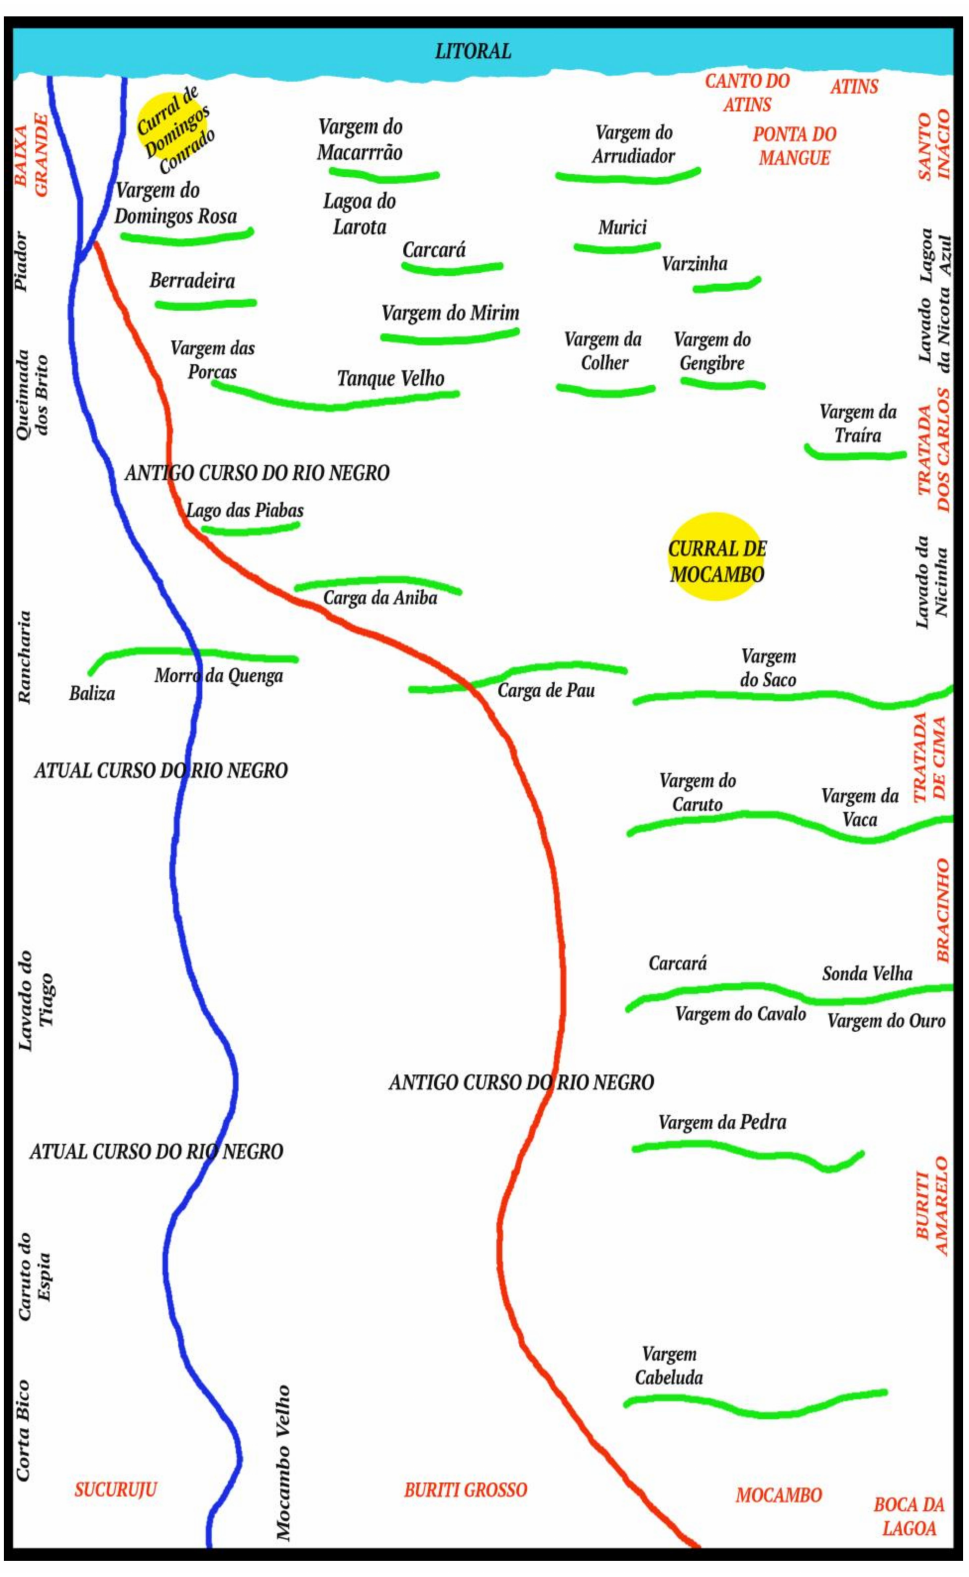
Figure 9. Native inhabitant’s mental map of a region of Lenç ó is Maranhenses National Park. In this mental map, Mr In á cio, 75 years old, indicates the vargens (pasture areas for goats and sheep—in green), the old and current courses of the Rio Negro (red and blue, respectively), the layout of corrals (in yellow) used in animal husbandry activities, and the arrangement of some traditional communities, highlighted in red font. Created by Mr. In á cio, from Mocambo. Reproduced by Benedito Souza